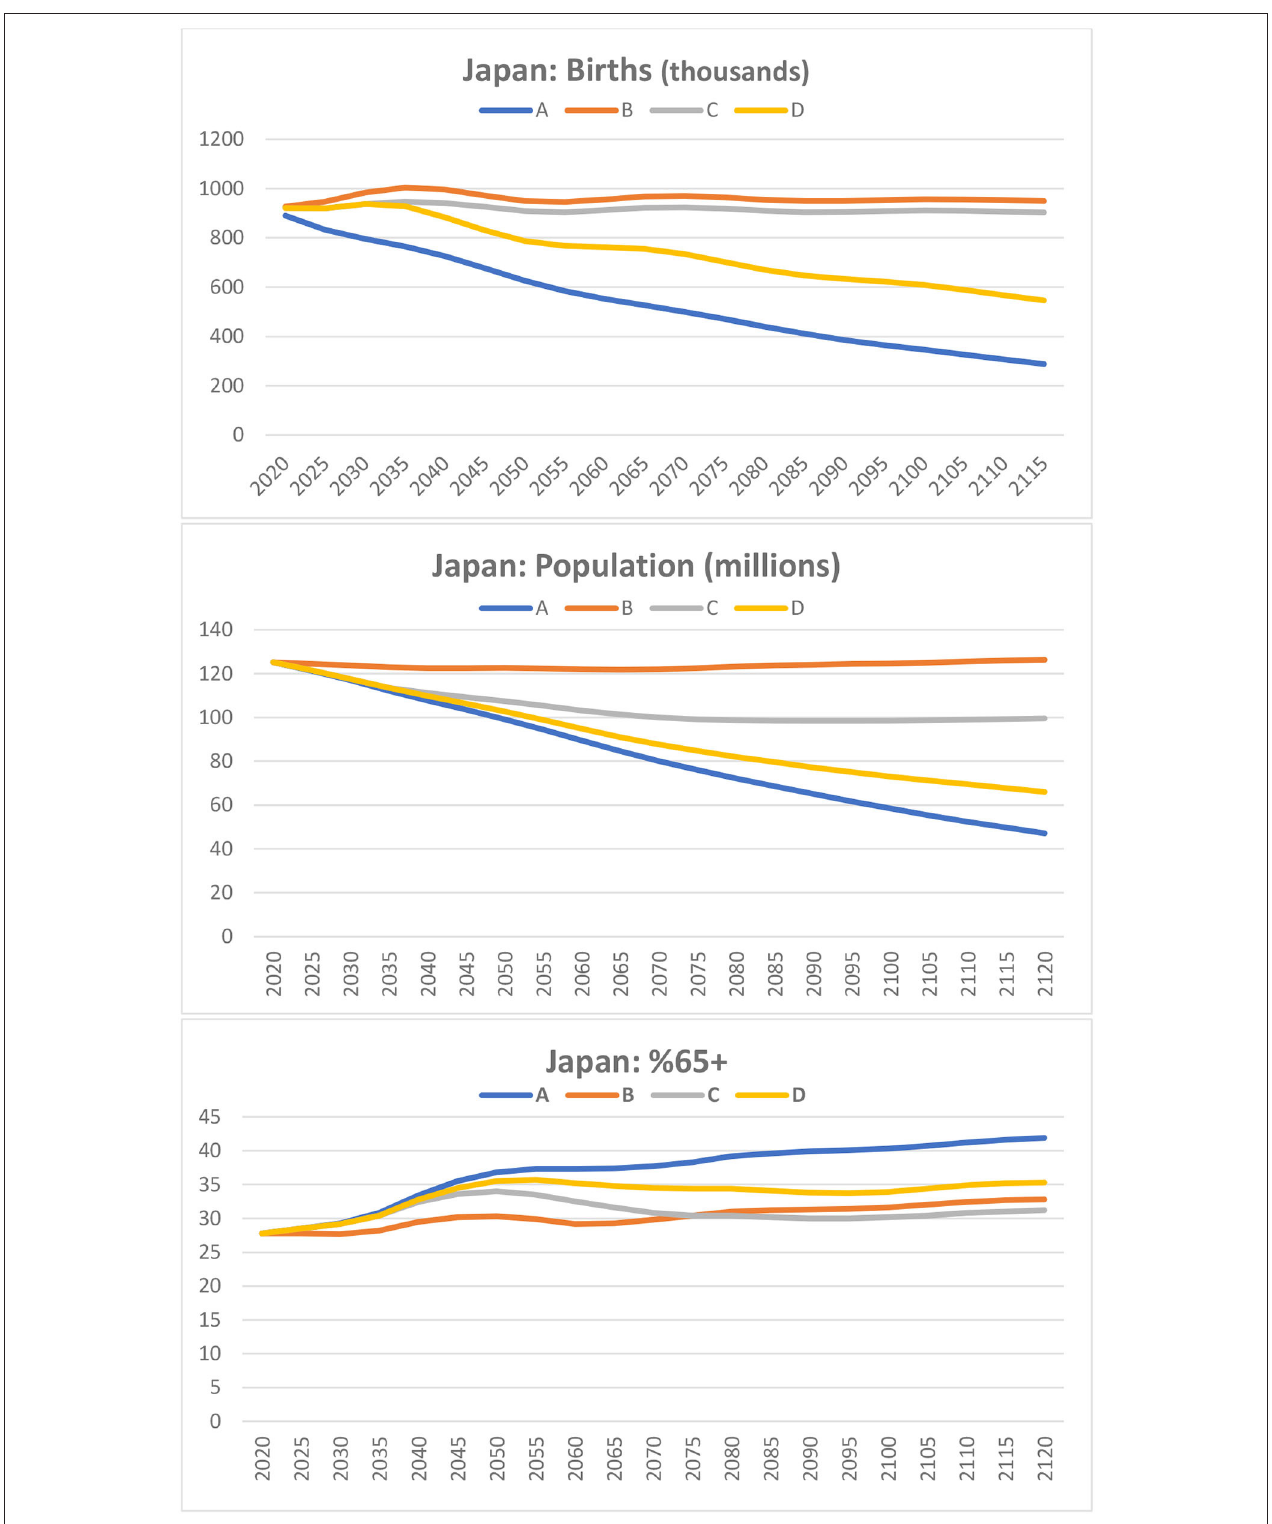
FIGURE 4 | Japan: Projections of births, population and percent of population aged 65 + . A: TFR = 1.4; Net migration = 0. B: TFR = 1.4: Net migration = 600,000 from 2020. C: TFR rises from 1.4 in 2020 to 1.7 in 2035; Net migration = 250,000 from 2035. D: TFR rises from 1.4 in 2020 to 1.7 in 2035; Net Migration = 0.